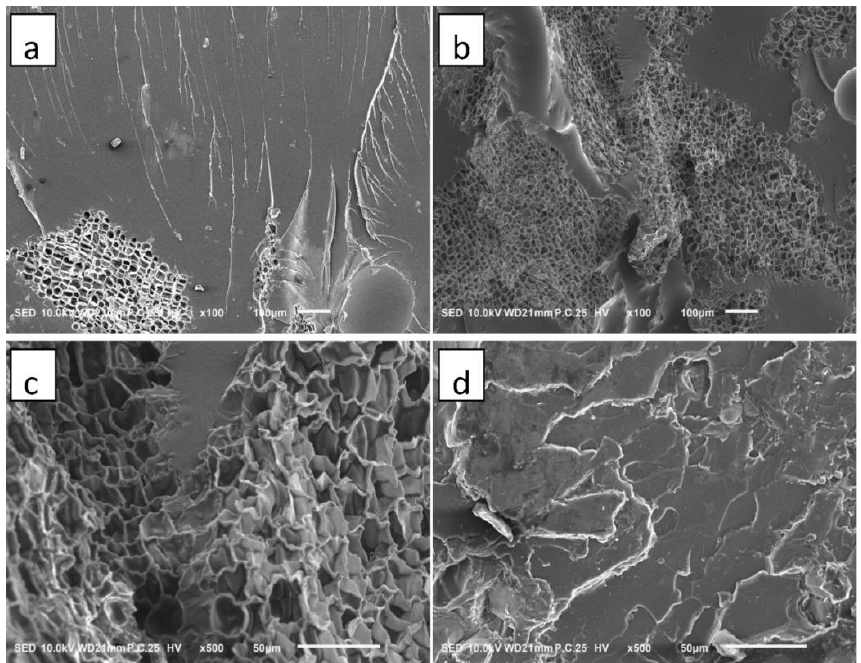
Figure 6. FE-SEM images of fracture surfaces for the cork/epoxy resin binary composites: ( a ) 1% cork, 40 – 100 mesh, ( b ) 5% cork, 40 – 100 mesh, ( c ) 5% cork, 40 – 100 mesh, ( d ) 5% cork, 200 – 300 mesh.